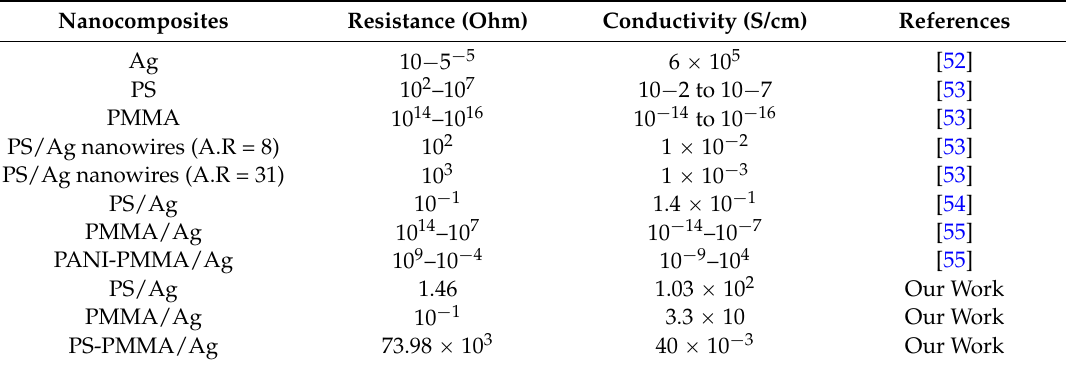
Table 2. Resistance and conductivity of polymer/AgNP nanocomposites.